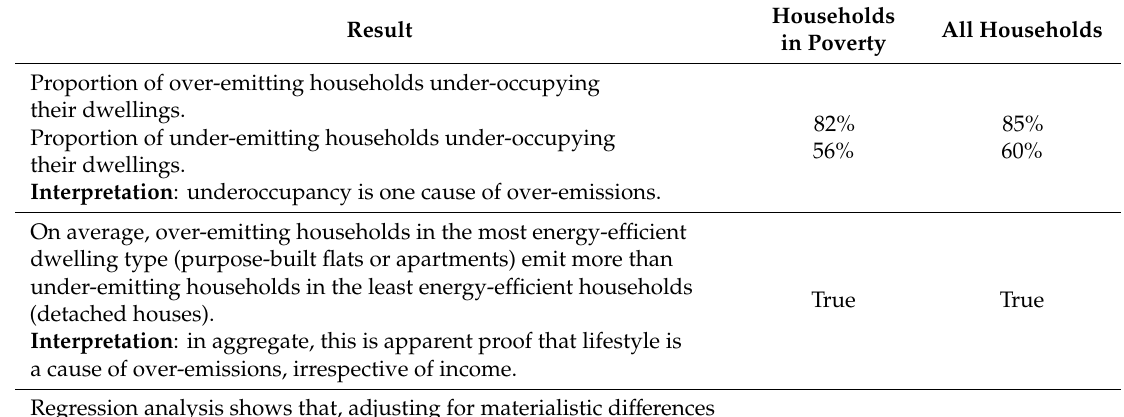
Table 5. Summary of key findings from data analysis. Result